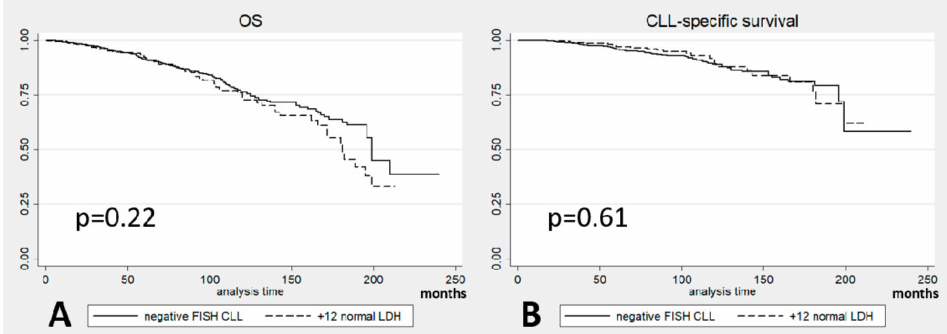
Figure 4. ( A ) Overall survival (OS) and ( B ) Chronic Lymphocytic Leukemia (CLL)-specific survival in + 12 CLL patients with normal Lactate DeHydrogenase (LDH) levels vs. Fluorescence In Situ Hybridization (FISH) negative CLL patients.